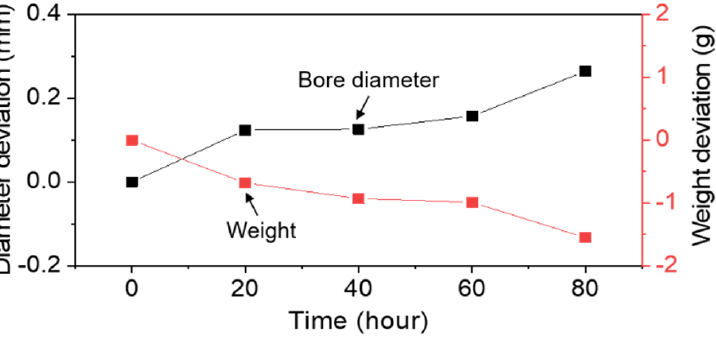
Figure 5. Nozzle bore diameters and weights at a waterjet pressure of 350 MPa and an abrasive feed rate of 450 g/min.